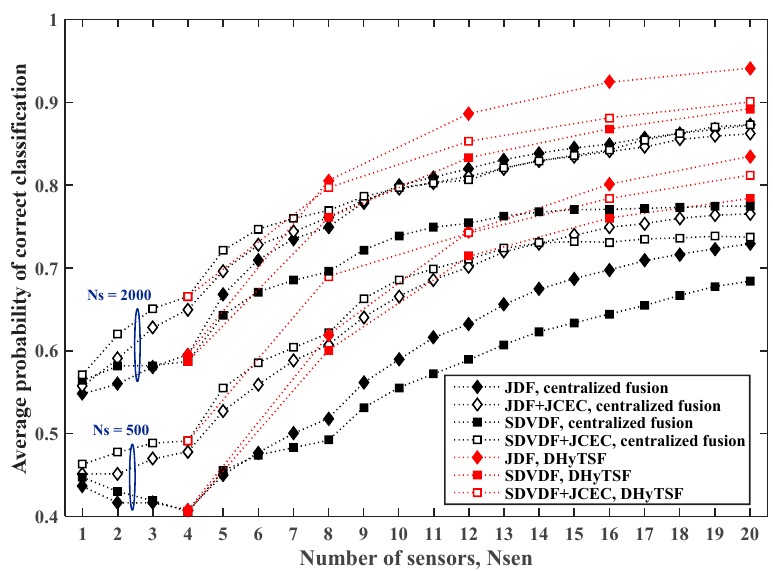
Figure 12. The estimated P CC , avg value for the centralized and distributed cooperative MC in SNS3, for N S = 500 and N S = 2000 and highly dispersive environment ( L max = 10 ). In the case of the less dispersive environment ( 𝐿 (cid:3040)(cid:3028)(cid:3051) = 5 ), the DHyTSF scheme slightly outperforms a centralized fusion with JCEC for the shorter symbol sequences ( 𝑁 (cid:3020) = 500 ), and achieves a similar performance for the longer sequences ( 𝑁 (cid:3020) = 2000 ). On the other hand, for the highly dispersive environment ( 𝐿 (cid:3040)(cid:3028)(cid:3051) = 10 ), the DHyTSF scheme clearly outperforms the centralized